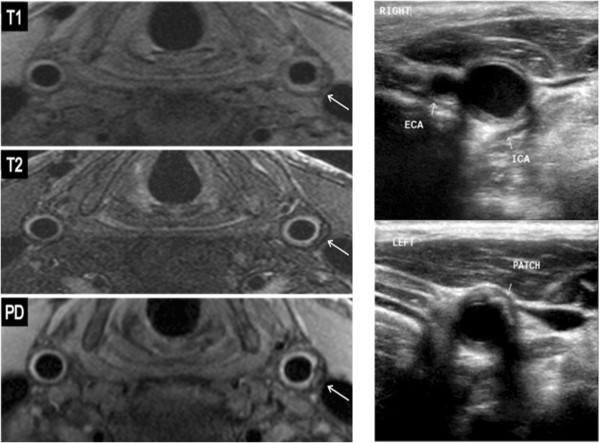
Patient with bilateral carotid endarterectomy five and a half years previously (2038 days); T1, T2 and PD weighting of both common carotid arteries shown (left). The right common carotid artery demonstrates a normal post-operative appearance, both on CMR and ultrasound (top right). However, a 30% restenosis of the left common carotid was noted on ultrasound (bottom right), which was seen as a crescent of predominantly low signal surrounding the artery on CMR (white arrows).